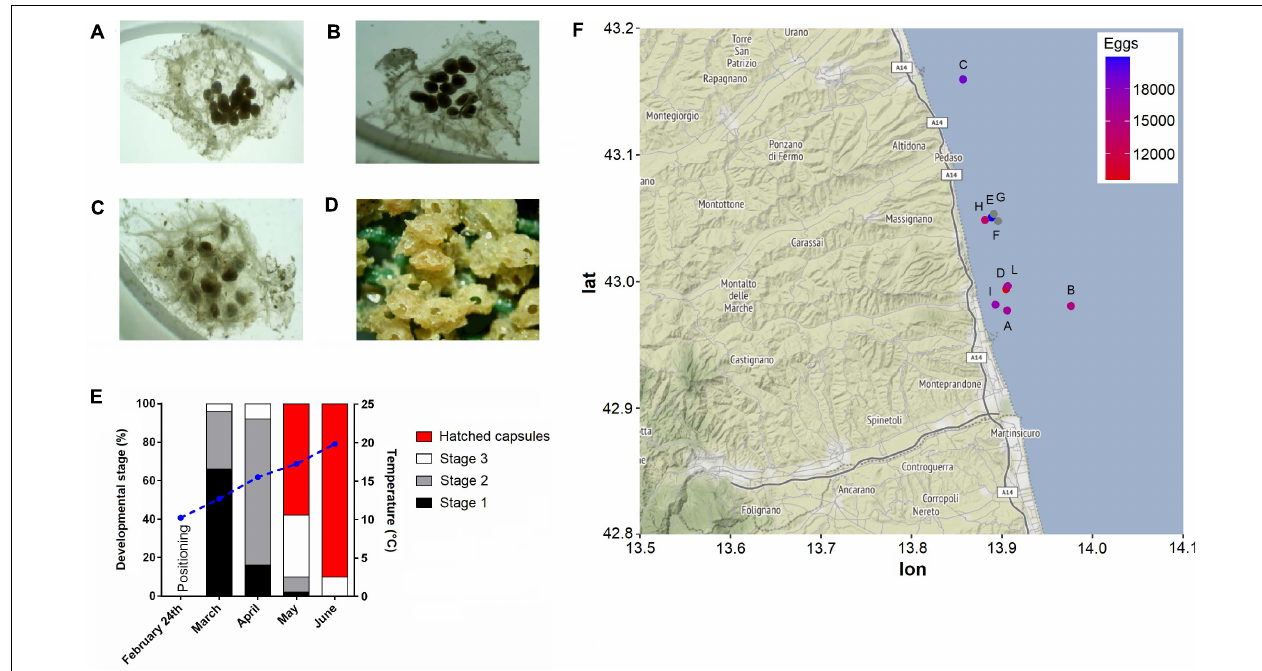
FIGURE 3 | Tritia mutabilis intracapsular embryonic development. Representative light microscope images of stage 1 (A) , stage 2 (B) , stage 3 (C) , and hatchling (D) . Monthly percentage of each developmental stage according to the temperature variation (blue straight line; E) . Heatmap of egg capsule amount (mean per pyramid) within each monitoring site (F) . Gray dots represent sites (i.e., F, G) that were not analyzed.